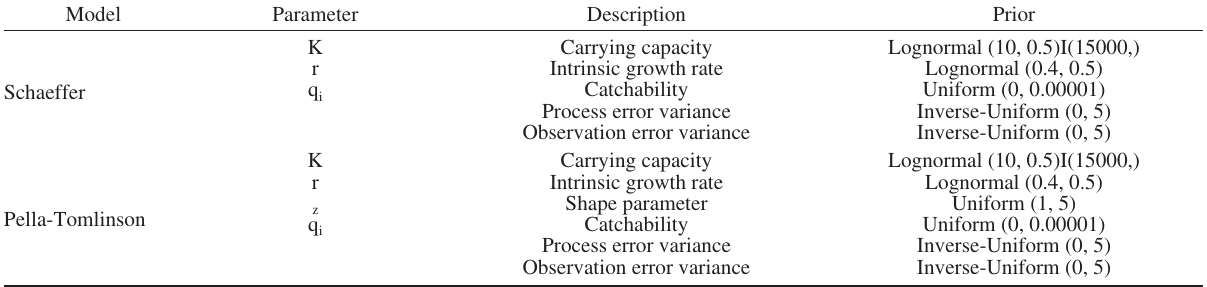
Table 1. – Summary of prior distributions for all model parameters in the Schaeffer and Pella-Tomlinson Bayesian state-space surplus produc- tion models.